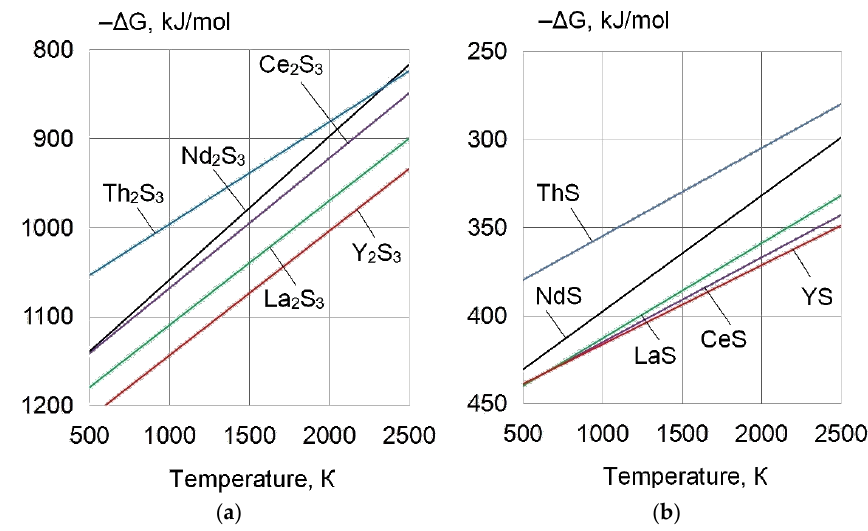
Figure 1. Gibbs free energies of the formation of ( a ) fluorides and ( b ) oxides of REEs.